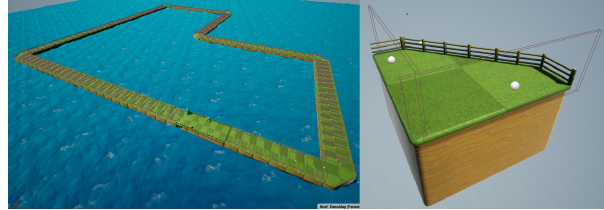
Figure 8. Cyclic road and curves’ system.